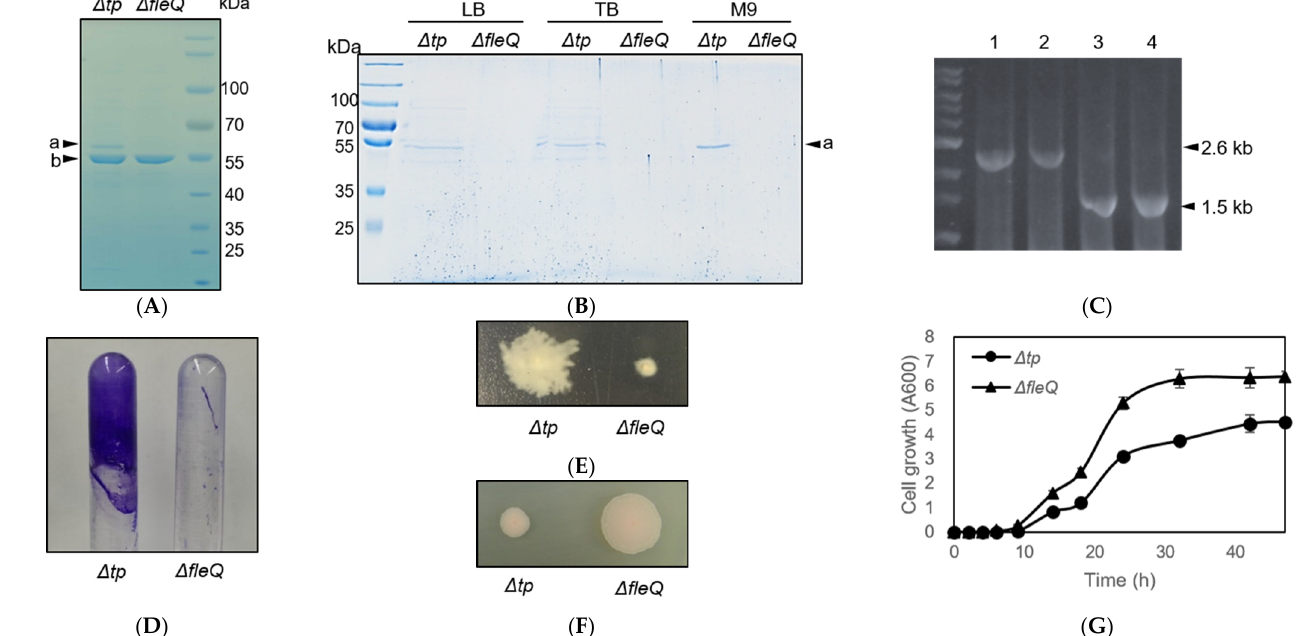
Figure 1. Verification and growth of P . fluorescens Δ fleQ mutant. ( A ) SDS-PAGE analysis of the proteins released in culture supernatant of P . fluorescens Δ tp and Δ fleQ transformed with pAJH10 which secrets TliA. “a“, FliC; “b“, TliA. ( B ) SDS-PAGE analysis of the proteins released in the culture supernatant of P . fluorescens Δ tp and Δ fleQ . ( C ) PCR products amplified from four P . fluorescens chromosomes using the F-PCR primer set. Sample: 1–2; wild type, 3–4; Δ fleQ . ( D ) Biofilm formation shown on the glass tube surface by staining with crystal violet. ( E ) Motility of P . fluorescens Δ tp and Δ fleQ on LB containing 0.3% agar. The cells were grown at 25 °C for 2 days. ( F ) The colony growth of P . fluorescens Δ tp and Δ fleQ on LB. The cells were grown on LB agar plates at 25 °C for 2 days. ( G ) Growth curves of P . fluorescens Δ tp and Δ fleQ .